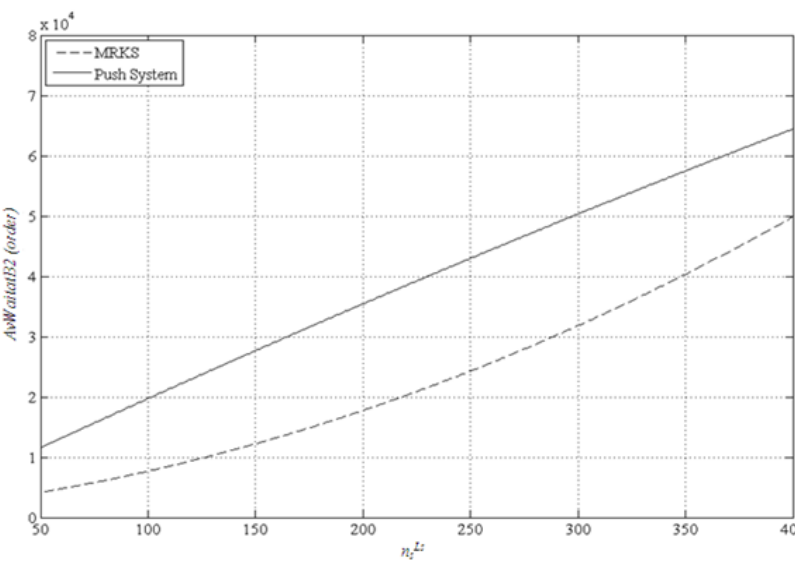
Figure 9. Box plot analysis on AvWaitatB2(order)